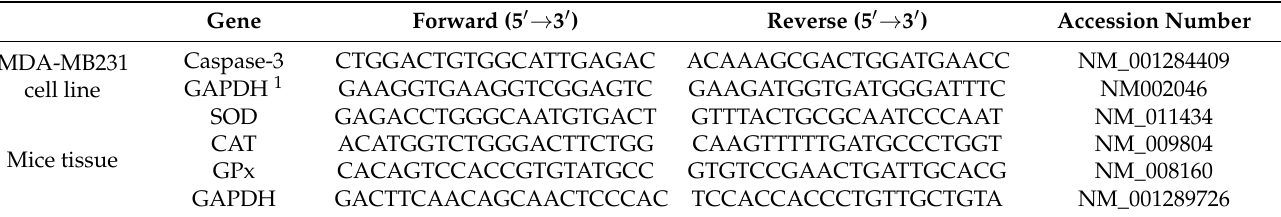
Table 1. Details of the primer sets used in the